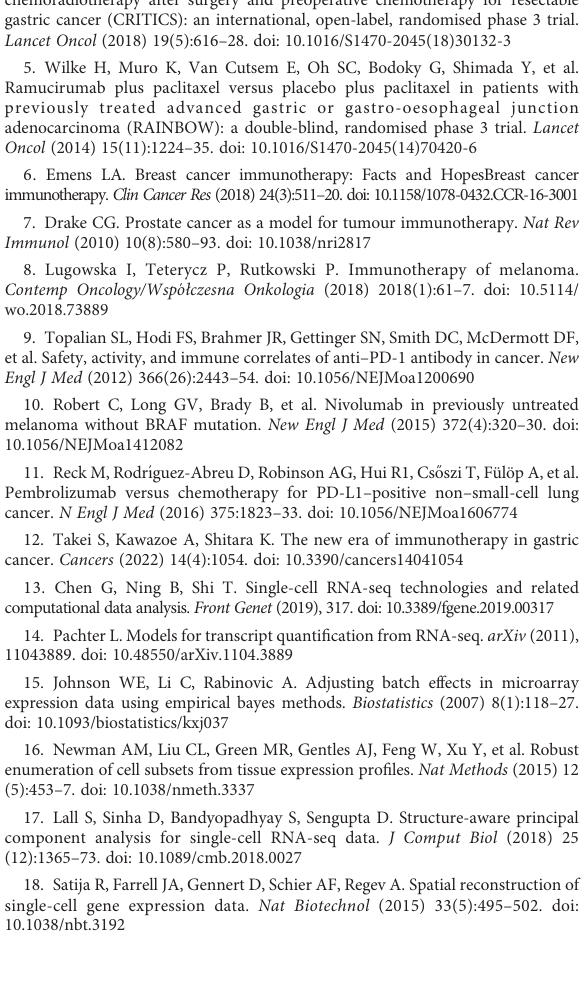
SUPPLEMENTARY FIGURE 5 Differential enrichment of KEGG pathways between low- and high-risk groups in the external validation cohort. SUPPLEMENTARY FIGURE 6 Differences in drug sensitivity between low- and high-risk groups in